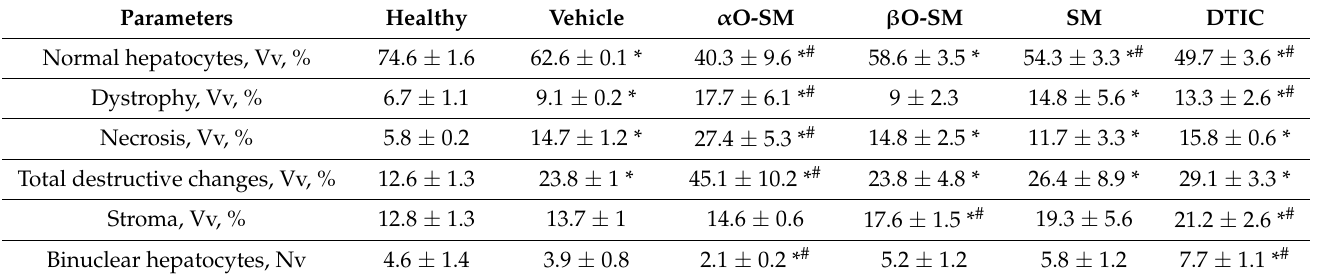
Table 3. Morphological changes in the liver tissue of healthy mice and mice with B16 melanoma without treatment and after administration of studied